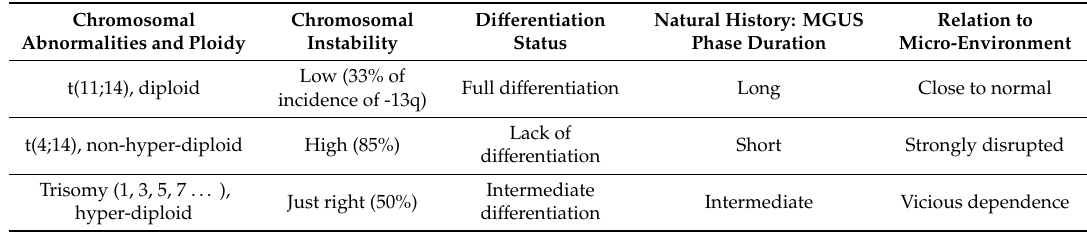
Table 1. Main correlations between genetics, epigenetics, di ff erentiation status, natural history, and